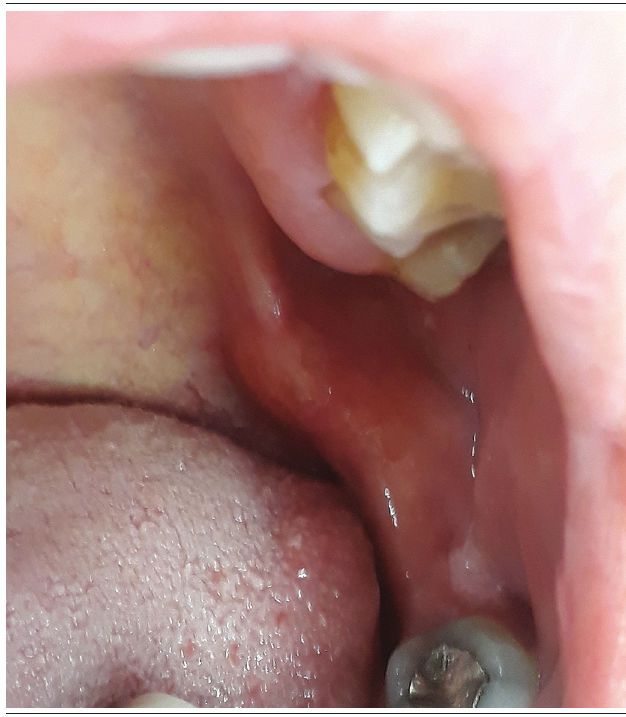
FIgure 1 – Nodular lesion in the right pterygomandibular raphe